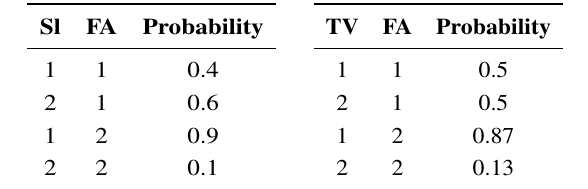
Table 2. Conditional probabilities.